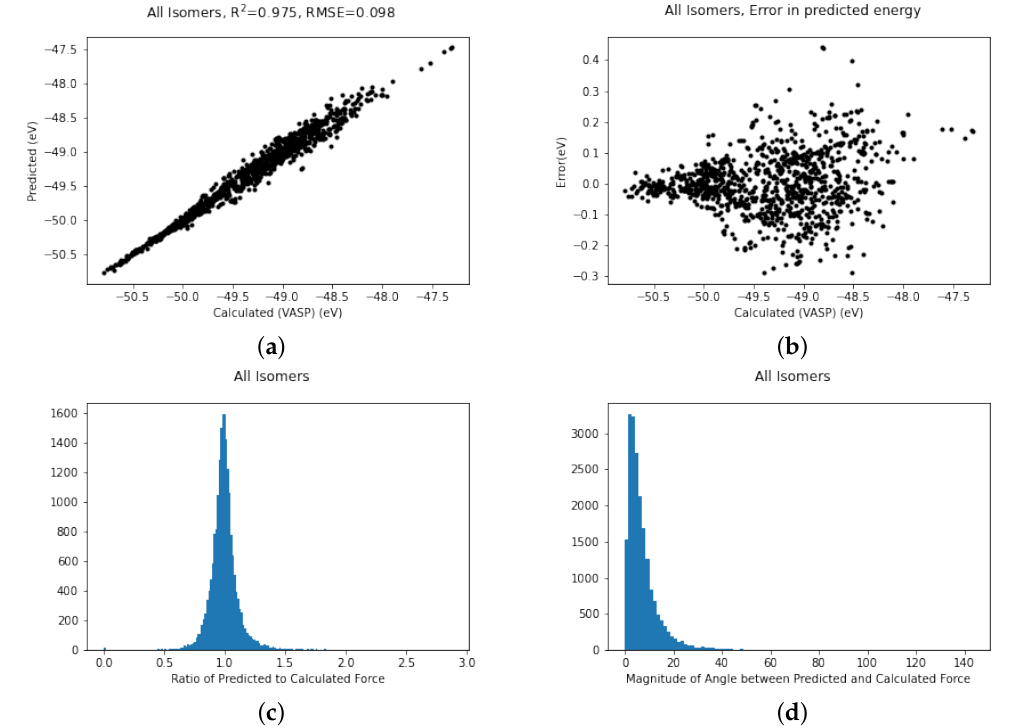
Figure 4. Plots of ( a ) Fits of energies, ( b ) scatter in energy error, ( c ) error in magnitude of forces and ( d ) error in direction of forces for all the gold cluster structures trained simultaneously.